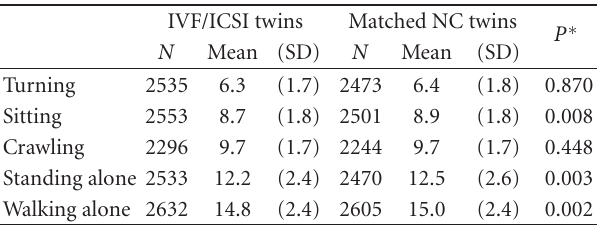
Table 3: Mean and standard deviation (SD) of ages (months) at which motor milestones are attained for IVF/ICSI twins and matched NC twins.